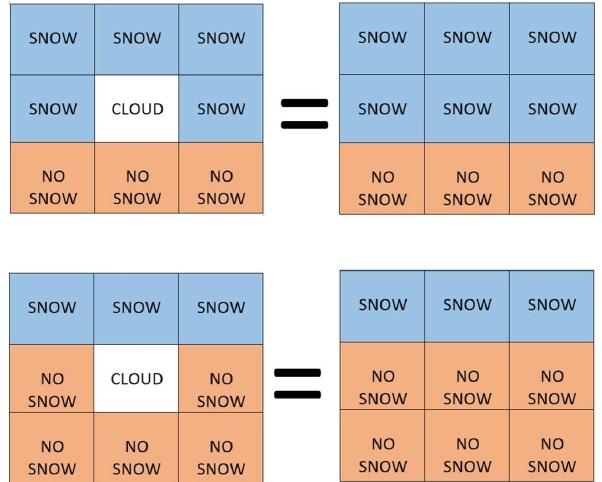
Figure 5. Cloud cover removed from the Terra product by seasonal filter, temporal filter, spatial filter, combining improved MOD10A2 and MYD10A2, and remaining cloud cover. The seasonal, tempo- ral, and spatial labels in the legend indicate the